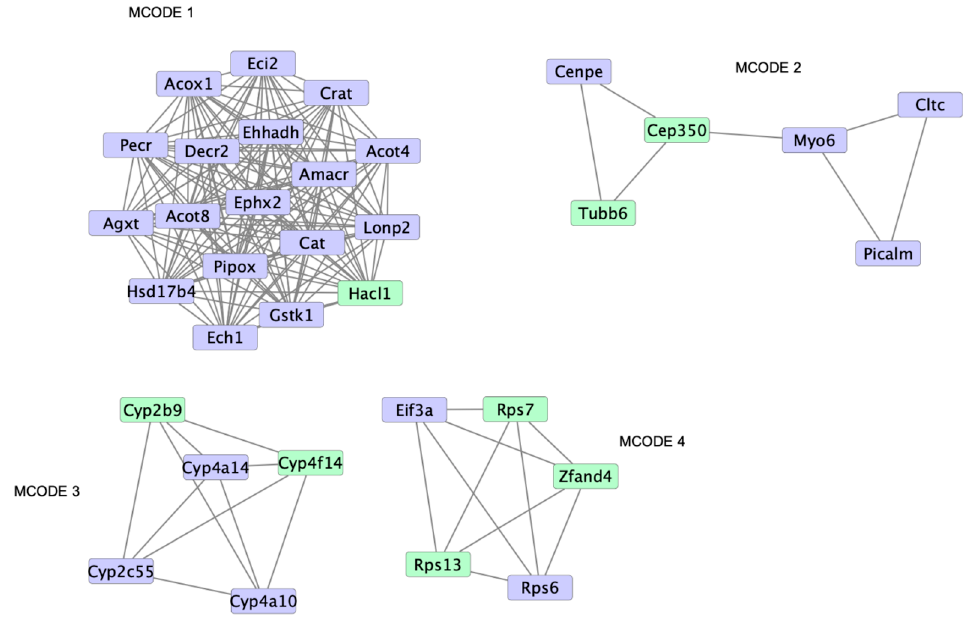
Figure 5. Protein–protein interaction enrichment analysis showing physical interactions formed among the upregulated (blue) and downregulated (yellow) proteins in Hacl1 − / − liver.